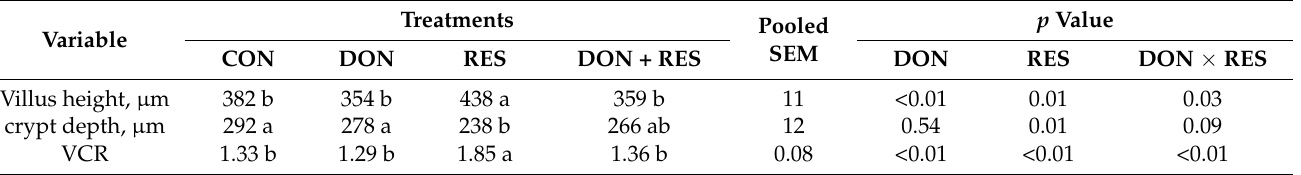
Table 7. Effect of resveratrol supplementation on intestinal morphology and tight junction proteins in DON-challenged piglets 1